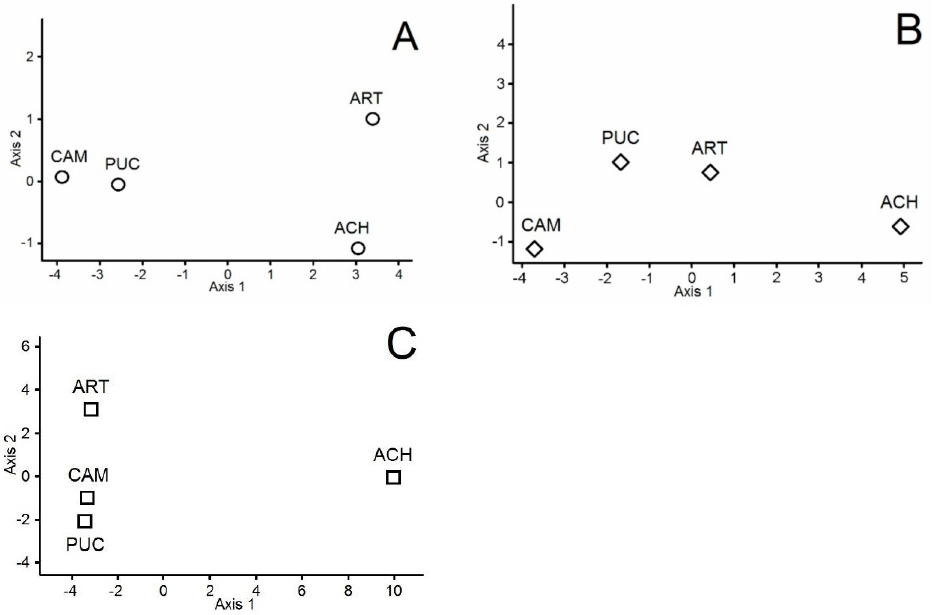
Figure 5. PCA ordination diagram for the four characteristic habitat types (at Apajpuszta, Hungary) according to soil microbial activity in June ( A ), soil microbial activity in September ( B ) and vegetation data ( C ). Abbreviations of habitats are the same as in Figure 4.